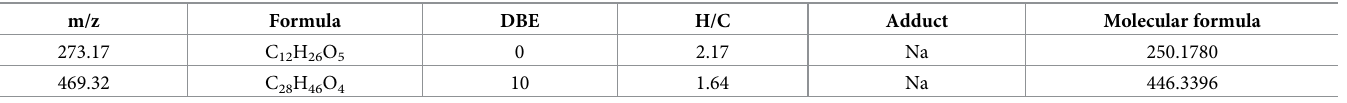
Table 2. Peaks incresing for oil I.